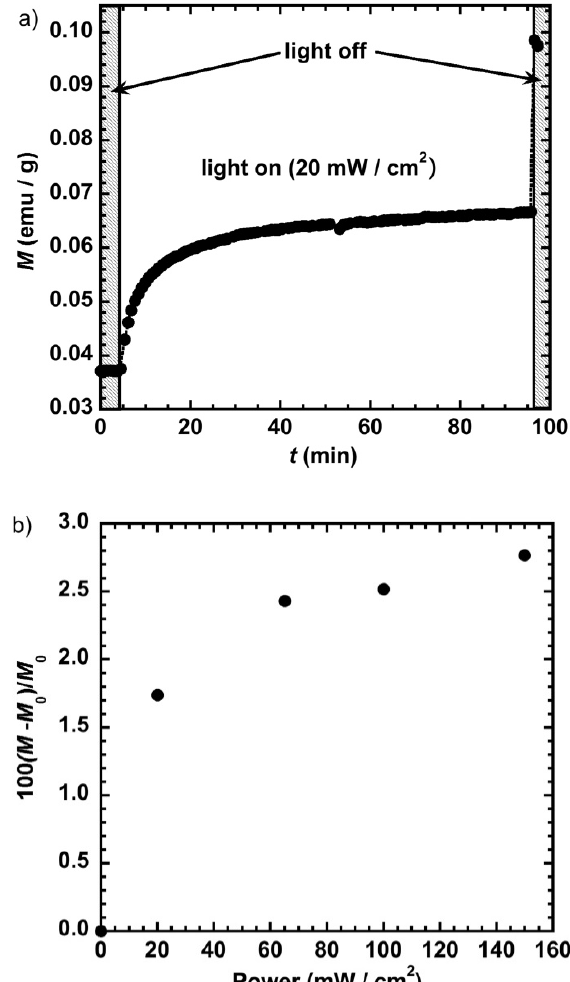
Figure 7. ( a ) Variation of the magnetization ( M ) with time ( t ) for a laser power of 20 mW/cm 2 and ( b ) reduced magnetization (( M − M 0 )/ M 0 )) performed at T = 10 K and B = 0.5 T showing the rate of increase of the magnetization after irradiation as a function of the laser power.